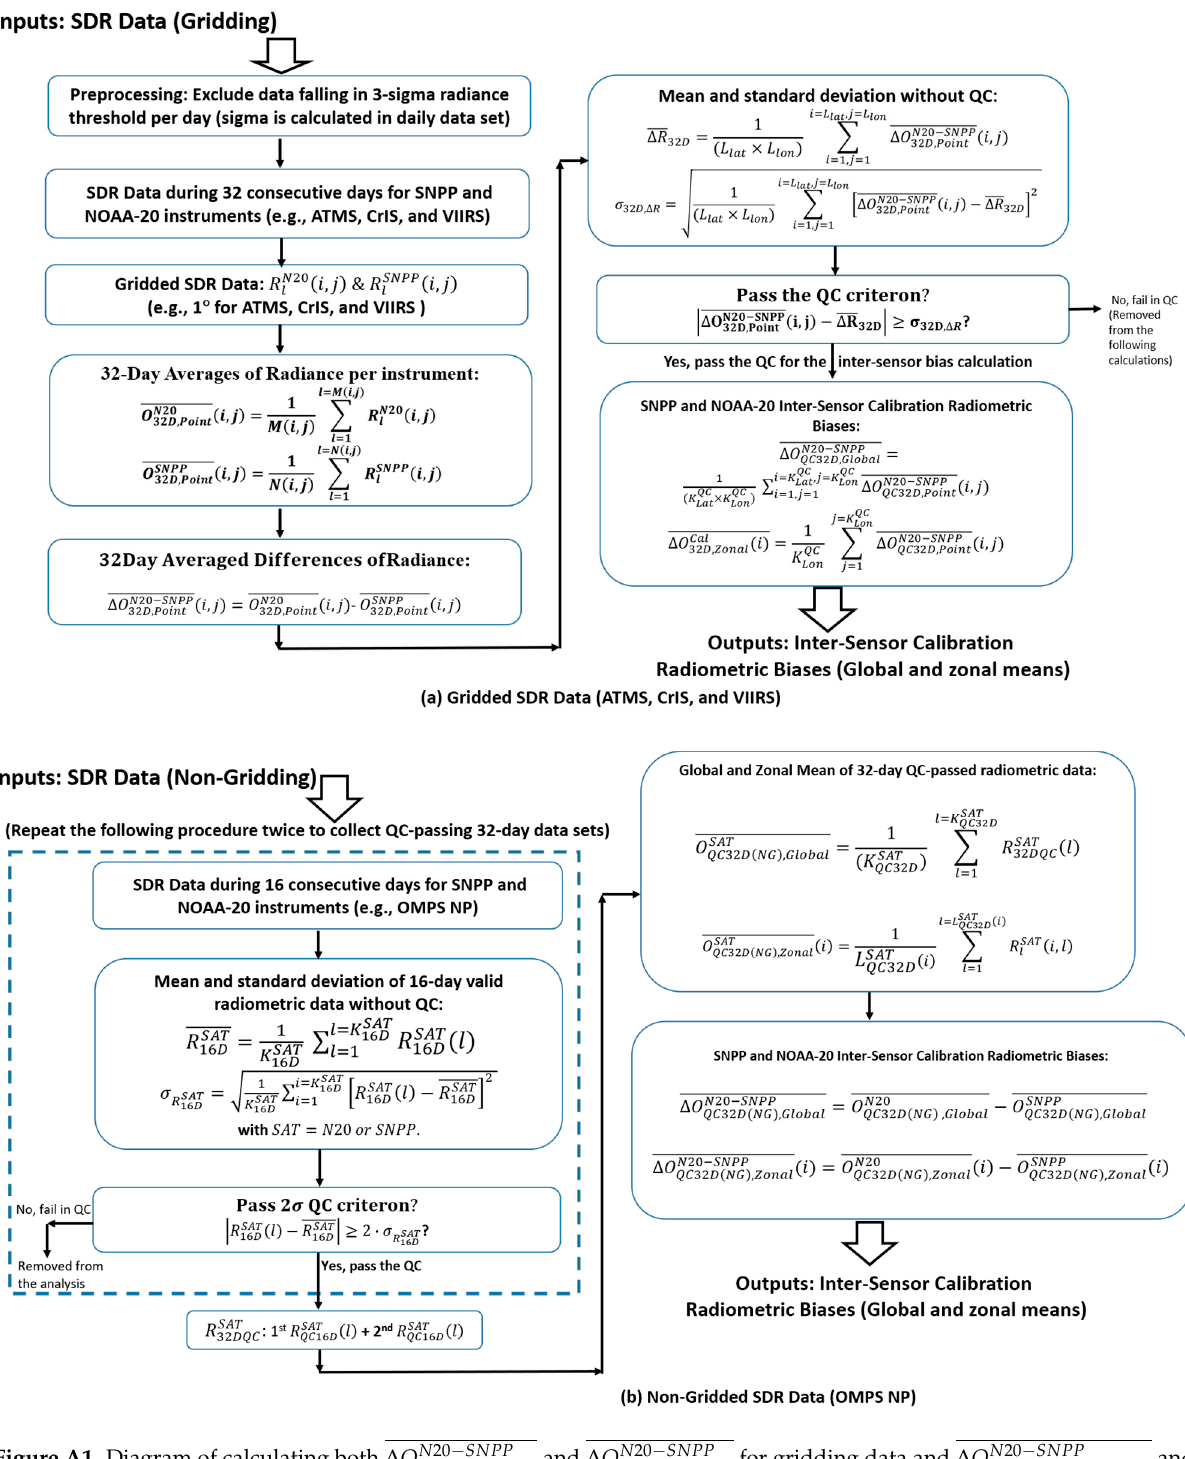
Figure A1. Diagram of calculating both ∆𝑂 (cid:3018)(cid:3004)(cid:2871)(cid:2870)(cid:3005),(cid:3008)(cid:3039)(cid:3042)(cid:3029)(cid:3028)(cid:3039)(cid:3015)(cid:2870)(cid:2868)(cid:2879)(cid:3020)(cid:3015)(cid:3017)(cid:3017) (cid:3364)(cid:3364)(cid:3364)(cid:3364)(cid:3364)(cid:3364)(cid:3364)(cid:3364)(cid:3364)(cid:3364)(cid:3364)(cid:3364)(cid:3364)(cid:3364)(cid:3364)(cid:3364)(cid:3364)(cid:3364) and ∆𝑂 (cid:3018)(cid:3004)(cid:2871)(cid:2870)(cid:3005),(cid:3027)(cid:3042)(cid:3041)(cid:3028)(cid:3039)(cid:3015)(cid:2870)(cid:2868)(cid:2879)(cid:3020)(cid:3015)(cid:3017)(cid:3017) (cid:3364)(cid:3364)(cid:3364)(cid:3364)(cid:3364)(cid:3364)(cid:3364)(cid:3364)(cid:3364)(cid:3364)(cid:3364)(cid:3364)(cid:3364)(cid:3364)(cid:3364)(cid:3364)(cid:3364)(cid:3364) for gridding data and ∆𝑂 (cid:3018)(cid:3004)(cid:2871)(cid:2870)(cid:3005)((cid:3015)(cid:3008)),(cid:3008)(cid:3039)(cid:3042)(cid:3029)(cid:3028)(cid:3039)(cid:3015)(cid:2870)(cid:2868)(cid:2879)(cid:3020)(cid:3015)(cid:3017)(cid:3017) (cid:3364)(cid:3364)(cid:3364)(cid:3364)(cid:3364)(cid:3364)(cid:3364)(cid:3364)(cid:3364)(cid:3364)(cid:3364)(cid:3364)(cid:3364)(cid:3364)(cid:3364)(cid:3364)(cid:3364)(cid:3364)(cid:3364)(cid:3364)(cid:3364)(cid:3364)(cid:3364) and ∆𝑂 (cid:3018)(cid:3004)(cid:2871)(cid:2870)(cid:3005)((cid:3015)(cid:3008)),(cid:3027)(cid:3042)(cid:3041)(cid:3028)(cid:3039)(cid:3015)(cid:2870)(cid:2868)(cid:2879)(cid:3020)(cid:3015)(cid:3017)(cid:3017) (cid:3364)(cid:3364)(cid:3364)(cid:3364)(cid:3364)(cid:3364)(cid:3364)(cid:3364)(cid:3364)(cid:3364)(cid:3364)(cid:3364)(cid:3364)(cid:3364)(cid:3364)(cid:3364)(cid:3364)(cid:3364)(cid:3364)(cid:3364)(cid:3364)(cid:3364)(cid:3364) for non-gridding data, respectively. The instruments in ( a ) include the ATMS, CrIS, and VIIRS, while the instrument in ( b ) is the OMPS NP in this study. In the diagrams, the sigma ( 𝜎 ) represents the standard deviation for the defined data sets; the subscript ‘ 𝑄𝐶 ′ is added to the variables to distinguish from the computations without the QC application; the equations are given in radiance but they are applicable for antenna temperature or brightness temperature. Explanations of other variables are referred to Table A1 in Appendix A. ( a ) Gridding data. ( b ) Non-gridding data.